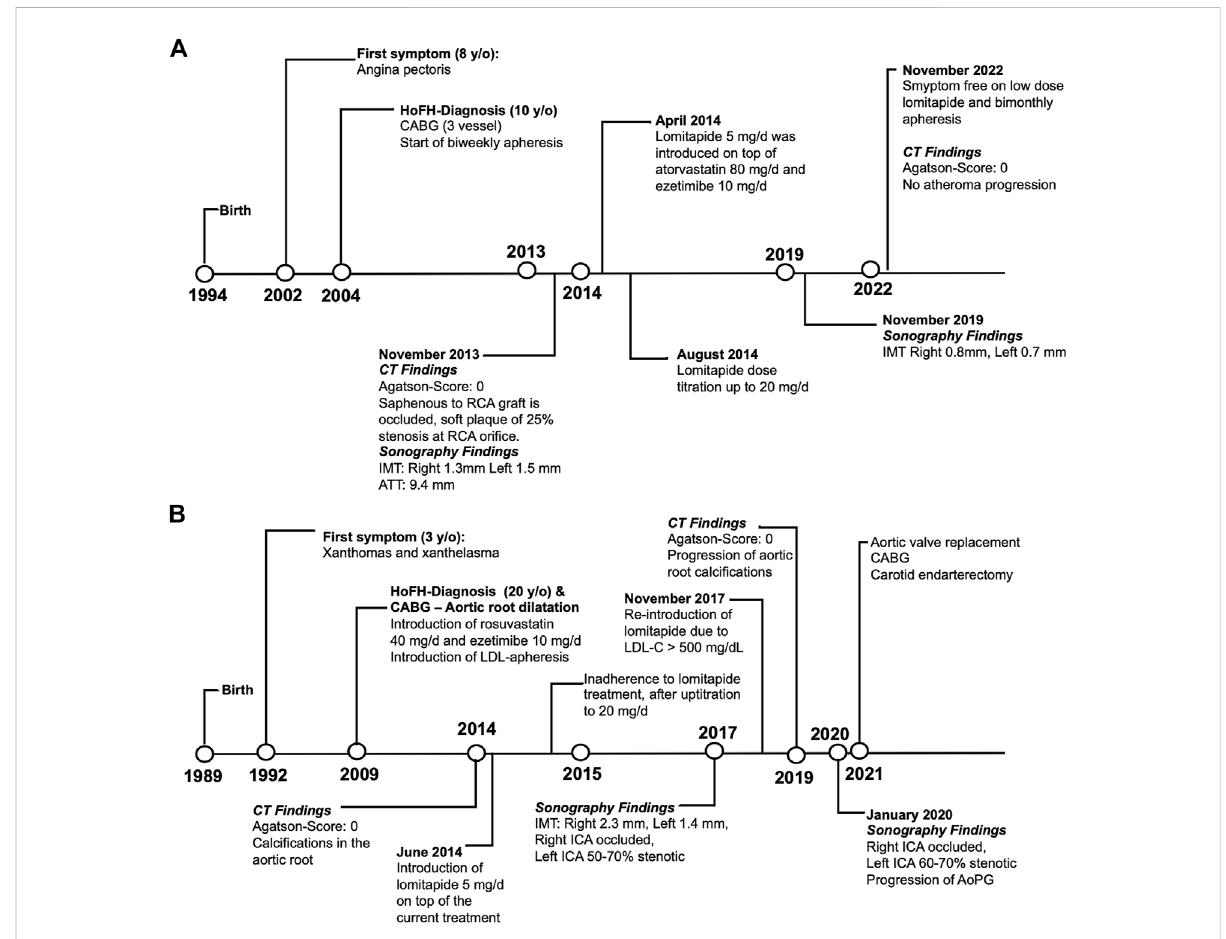
FIGURE 1 Timeline schema representing the clinical evolutions of Cases 1 (A) and 2 (B) . Abbreviations : CABG,coronary artery bypass graft; CT, computed tomography; ICA, internal carotid artery; RCA, right coronary artery; IMT, intima-media thickness; ATT, Achilles tendon thickness; HoFH, homozygous familial hypercholesterolemia; AoPG, aortic peak gradient; LDL-C, low-density lipoprotein